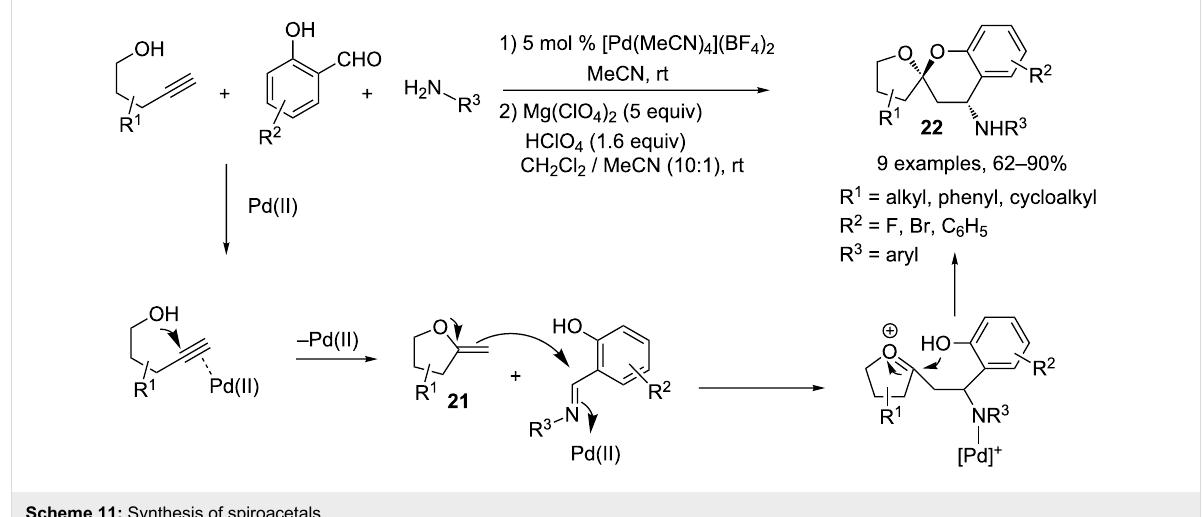
Scheme 11: Synthesis of